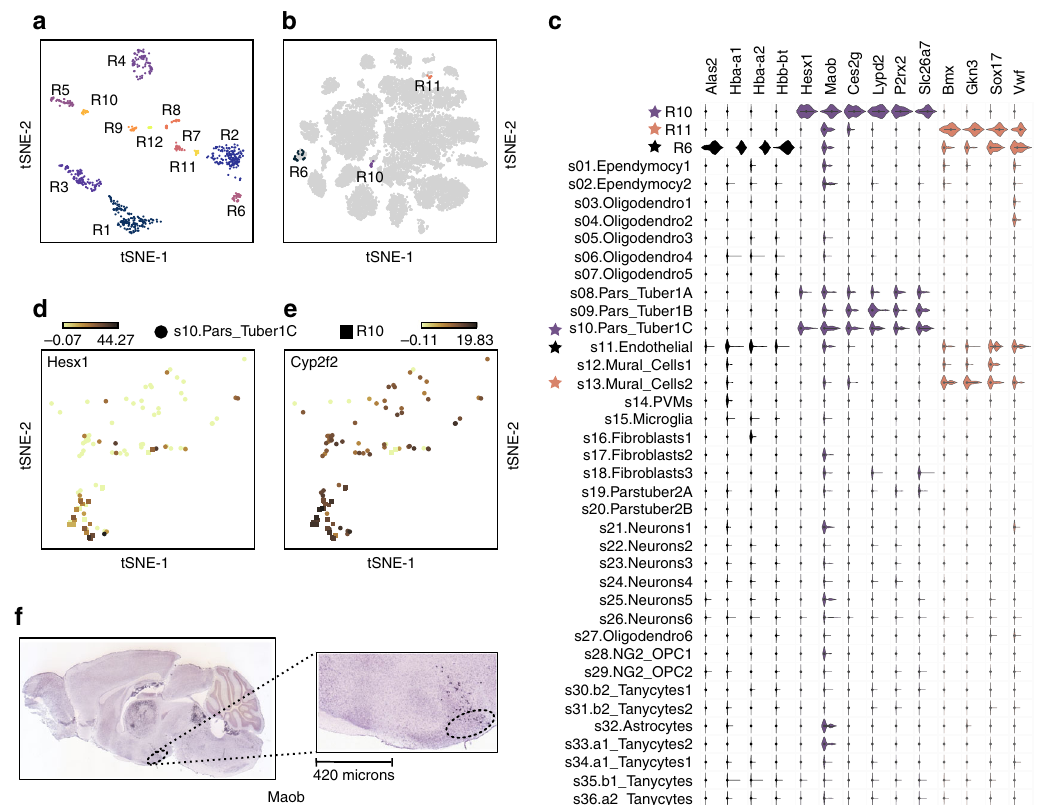
Fig. 6 Identi fi cation of novel, rare cell types from mouse brain cell data 5 . a Clustering of rare cells detected by FiRE from the ~20 k mouse brain data using dropClust 24 . Predicted clusters numbered R1 – R12 are shown in a t-SNE-based 2D map. b Three clusters (R6, R10, R11) out of the 12 clusters, characterized further, are marked on the two-dimensional t-SNE plot adopted from the original study 5 . Notably, all three cell subpopulations appear to be inscribed within some high-level clusters reported by Campbell et al. 5 . c Violin plots showing the expression distribution of some of the cell type-speci fi c genes uniquely marking the newly discovered minor subpopulations. Minor cell subpopulations and their corresponding parent clusters have been pre fi xed with asterisks of the same color. d Cells in R10 express high levels of Hesx1 . e R10 expressed Cyp2f2 , a known marker of its parent sub-type s10-pars tuber 1c 5 . f Maob in situ hybridization in a sagittal view of Arc region of brain (scale = 420 µ m), obtained from the Allen Mouse Brain Atlas